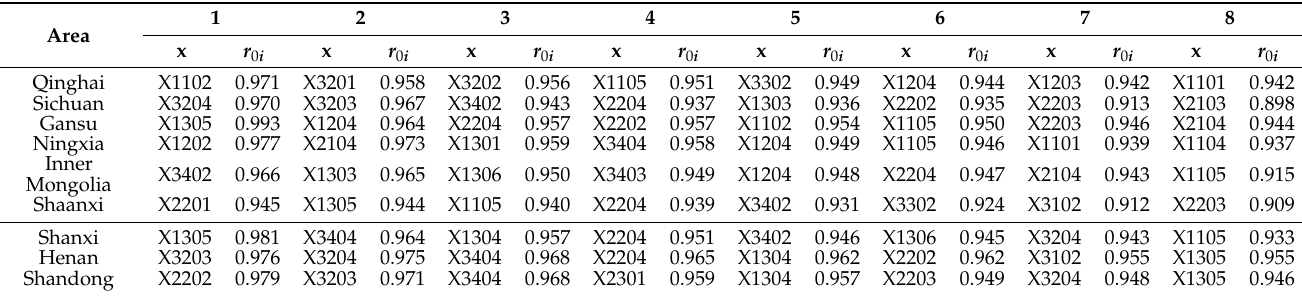
Figure 5. Coordination index spatial distribution: ( a ) is the distribution of 2009 and ( b ) is the distribution of 2019. Table 7. Calculation results of the correlation degree.